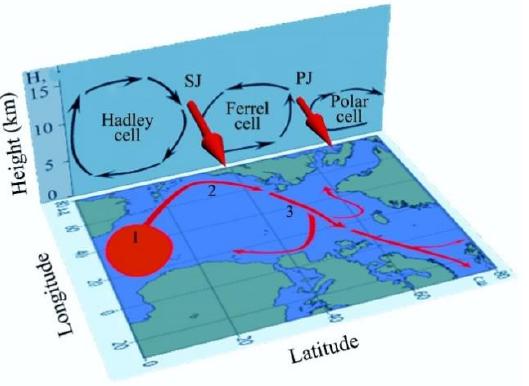
Figure 2. The scheme of SST influence spreading from the North Atlantic tropics to the Arctic.